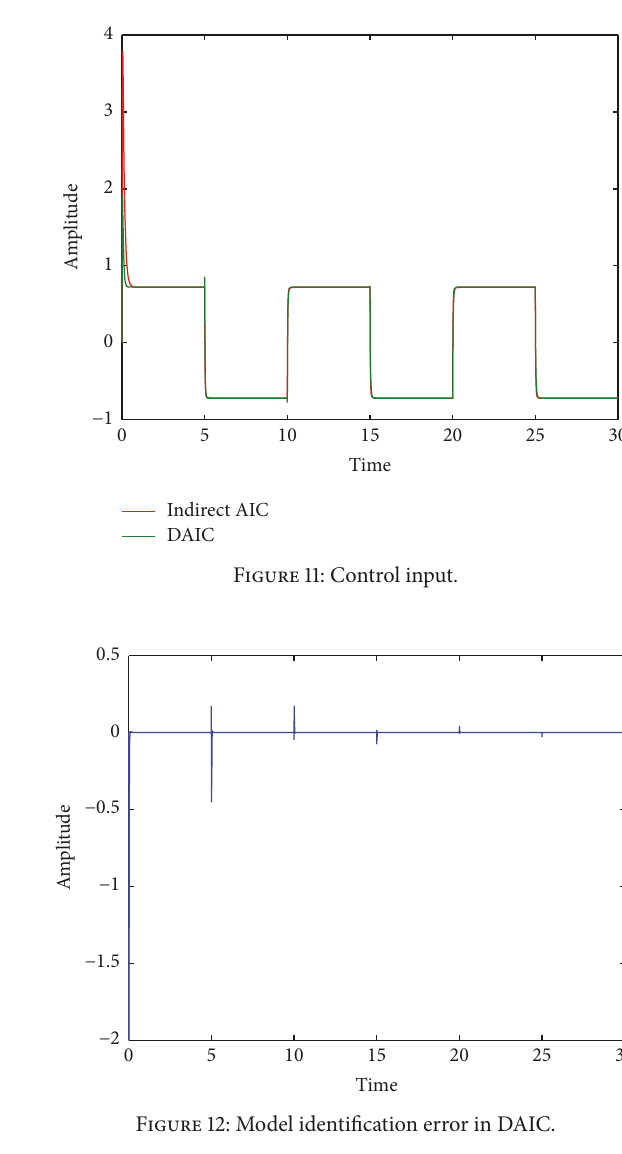
Figure 12: Model identification error in DAIC.